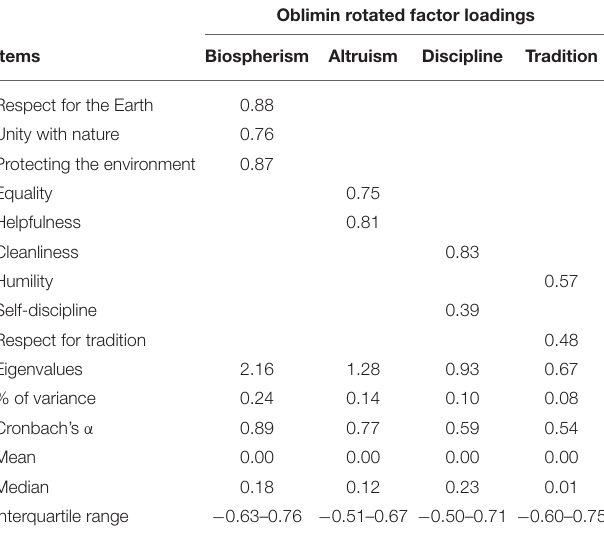
TABLE 6 | Summary of the exploratory factor analysis results for the questions related to personal values of 233 dairy